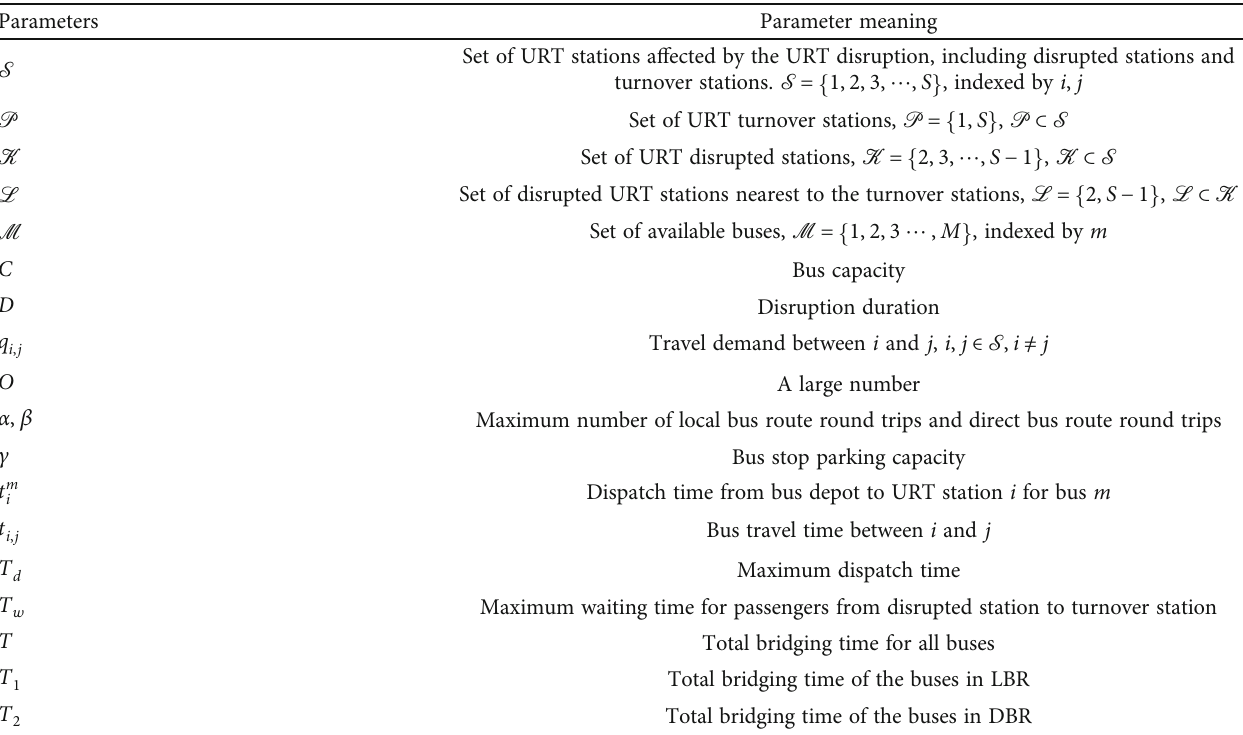
Table 2: Model key parameter de fi nition.